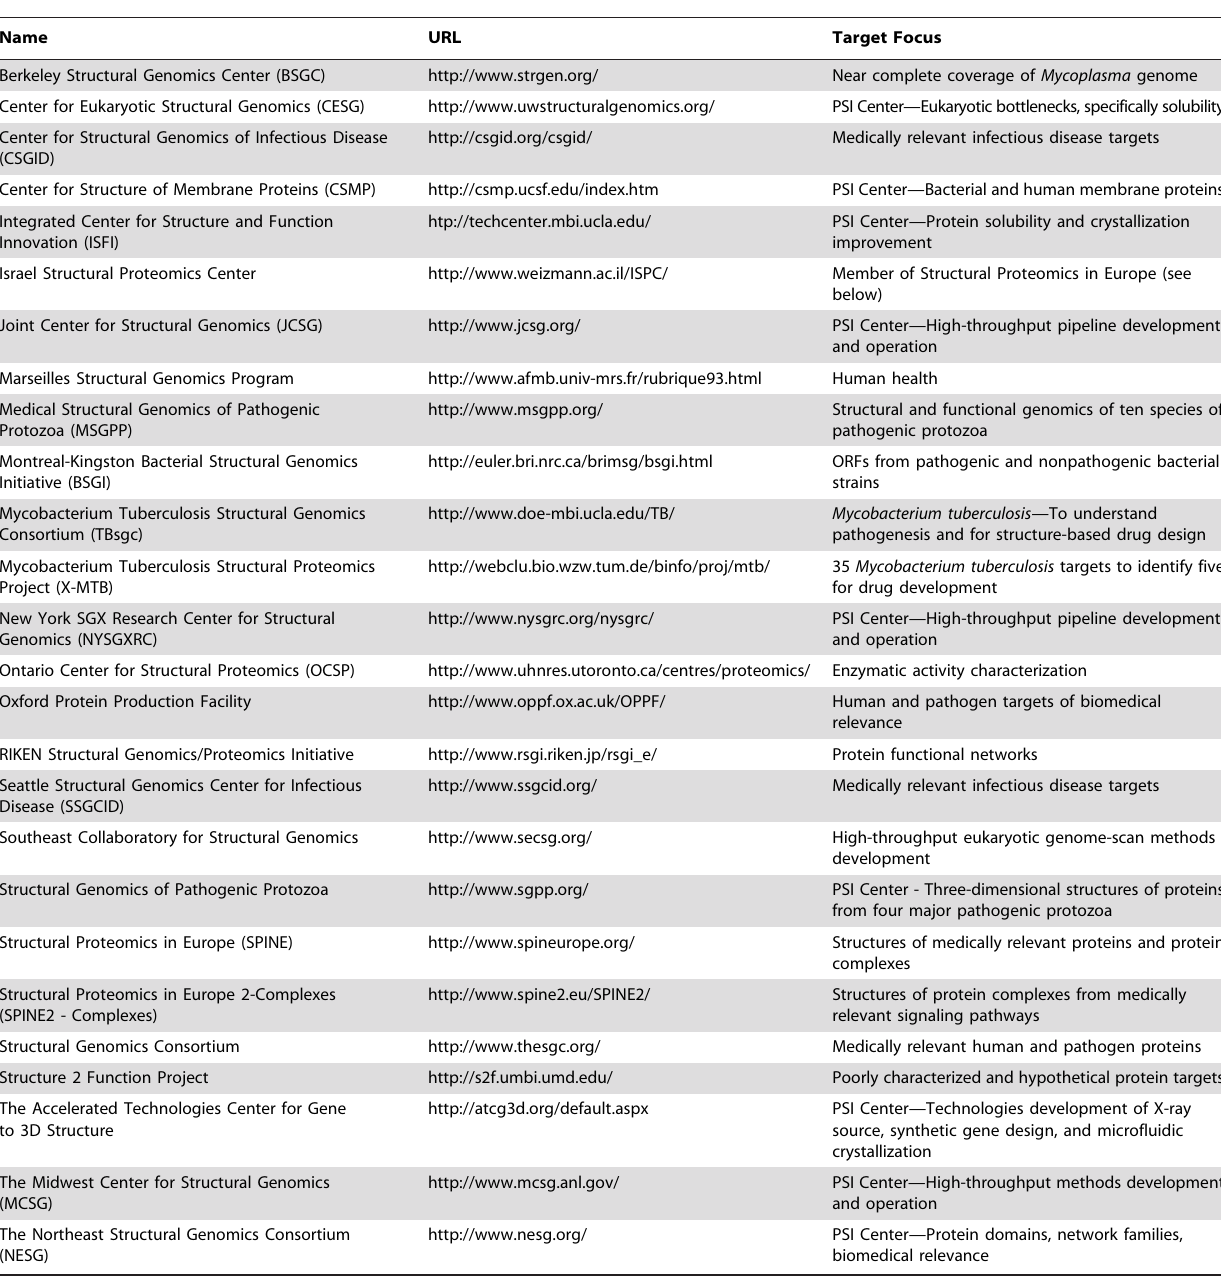
Table 2. Structural genomics projects worldwide submitting to the Protein Data Bank.